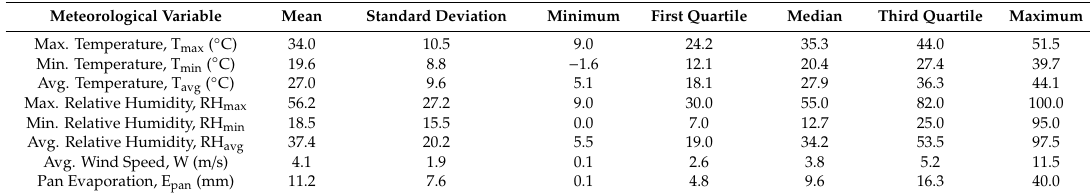
Table 1. Basic statistics of the daily meteorological measurements at KIA station from January 1993 to July 2015.